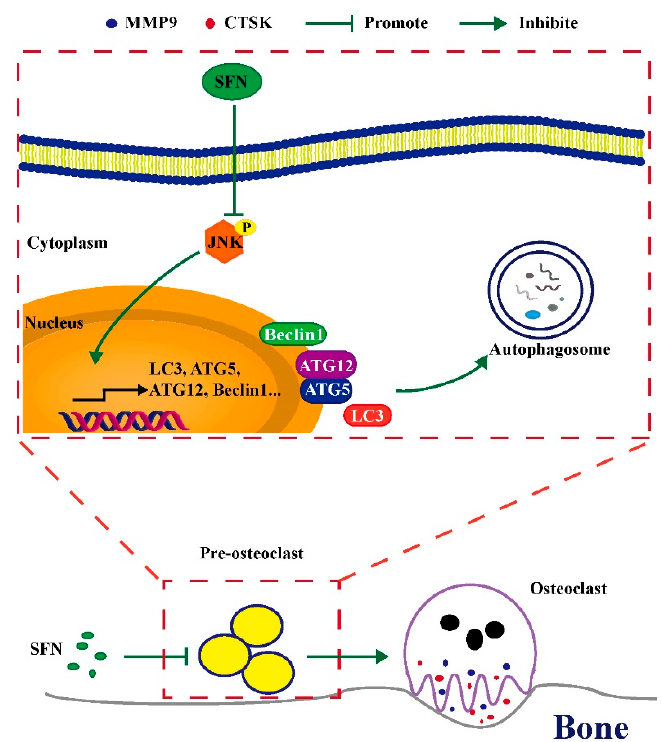
Figure 7. Schematic model of SFN-mediated anti-osteoclastogenesis. SFN inhibits the phosphorylation of JNK, decreasing the expression levels of autophagic proteins (Atg5, Atg12, Beclin1, and LC3). Subsequently, the level of osteoclastic autophagy is attenuated, which consequently suppresses osteoclastogenesis and bone erosion.